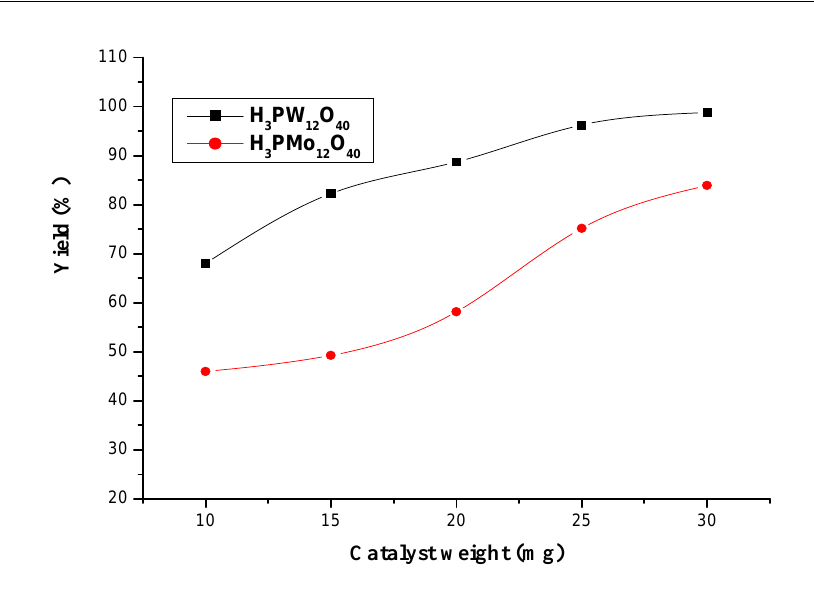
Figure 6. Effect of the amount of catalyst on styrene polymerization (in dichloromethane) using H PW O and H PMo O catalysts. Polymerization was carried out at 25 ºC 3 12 40 3 12 40 during 5